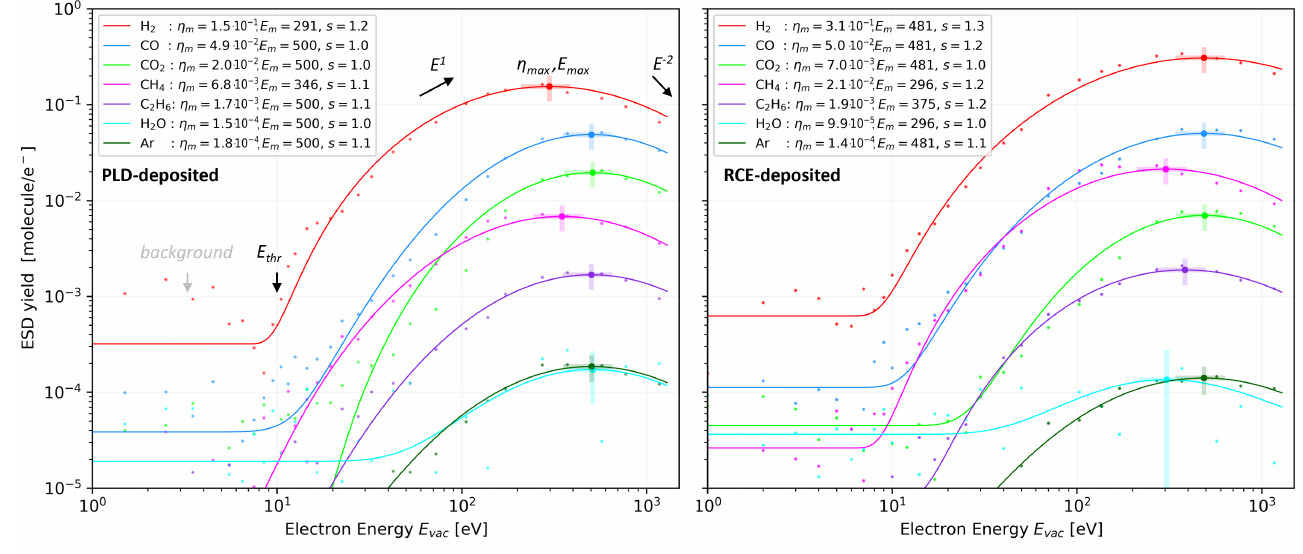
Figure 4. ESD energy dependence of as–received REBCO samples. The RCE–deposited sample ( right ) is characterized at 12K and PLD–deposited at 19K ( left ). Note the high uncertainty for water on the right plot, partially due to the high background and partially due to the low signal–to–noise ratio. The best–fit parameters for Equation (4) are listed in the legend. More details are in the